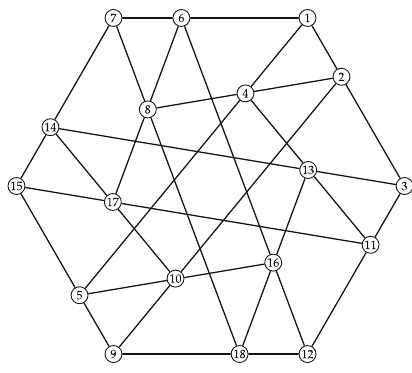
Figure 16: The unique 18 372 - con fi guration inducing a triangular